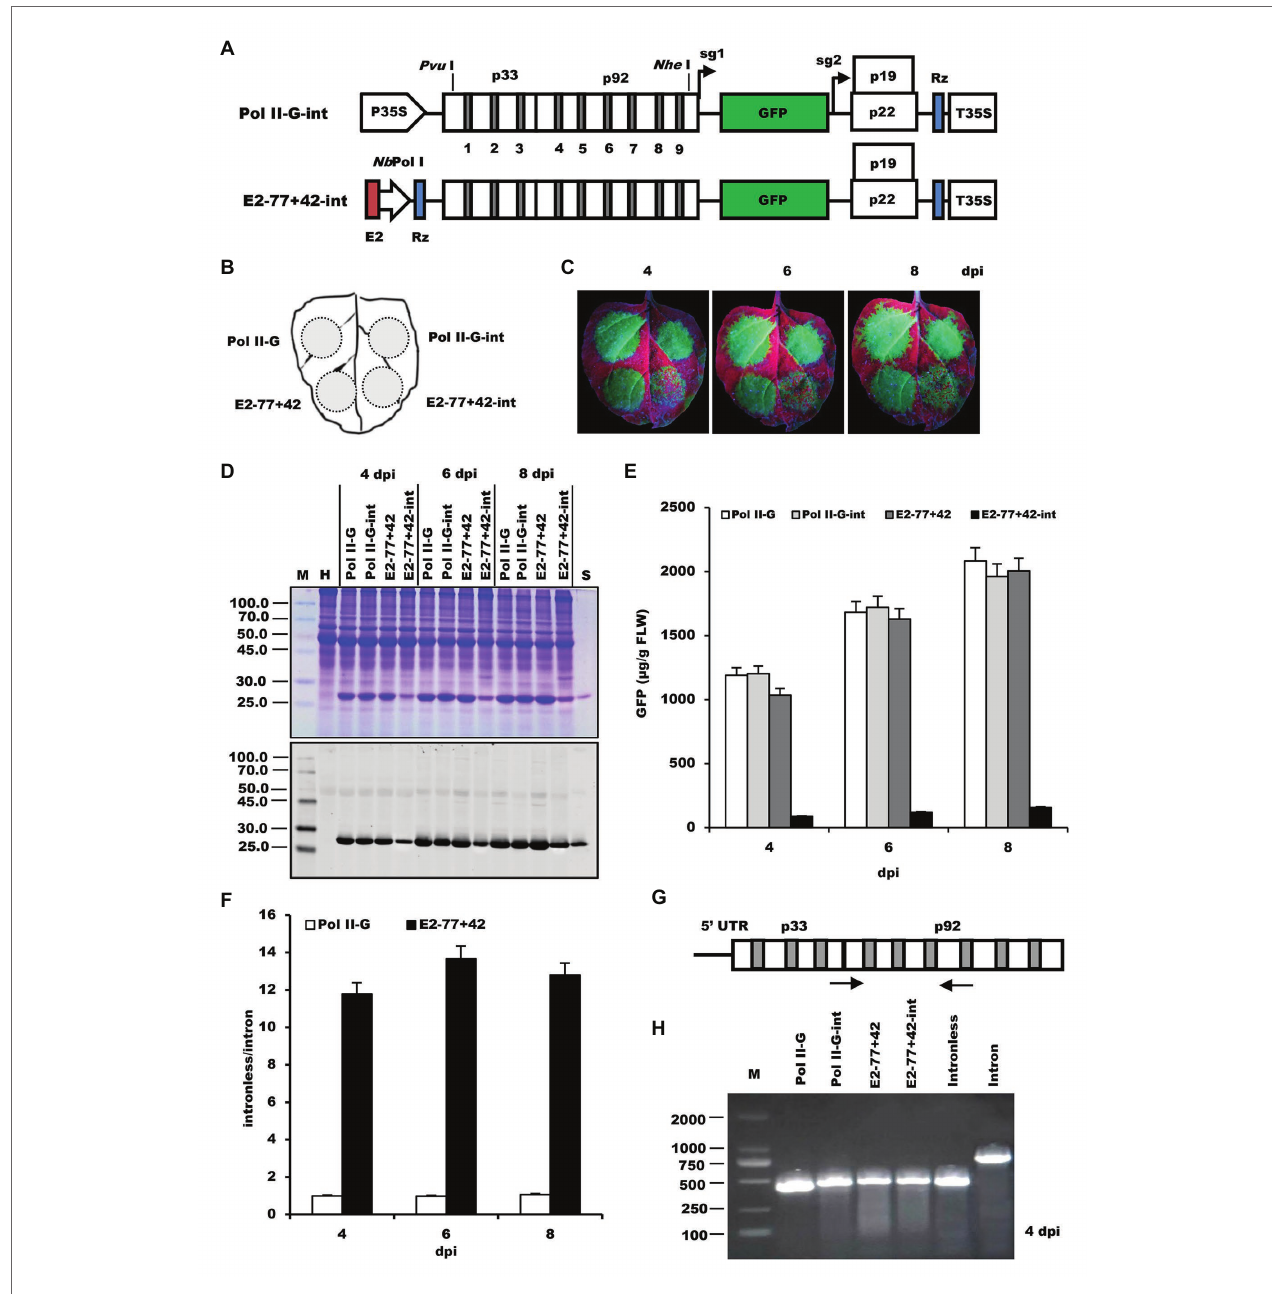
FIGURE 4 | Testing the transcription specificity of the Nicotiana benthamiana rRNA ( Nb rRNA) gene promoter by an intron-excision mediated assay. (A) Schematic representation of the intron-containing Pol I-promoter- or Pol II-promoter-based TBSV vectors. P35S, 35S promoter; p33 and p92, the gene coding replication proteins; sg1 and sg2, the TIS for subgenomic mRNAs 1 and 2 indicated by right-angled arrows; green fluorescent protein (GFP), enhanced green fluorescent protein gene; p19, silencing suppressor gene; p22, cell-to-cell movement protein (MP) gene; Rz, ribozyme; T35S, cauliflower mosaic virus (CaMV) polyA signal sequence/terminator; Pvu I and Nde I, restriction enzymes sites; E2, ELS from enhanced 35S promoter; Nb Pol I, modified Nb rRNA gene promoter ( − 77+42). The light gray box in the p33 and p92 regions shows the positions of the different introns. (B) Schematic representation of the infiltrated zones in N. benthamiana leaf. (C) GFP expression pattern (under UV light) of agroinfiltrated leaves at 4, 6, and 8 days post-inoculation (dpi), respectively. (D) SDS-PAGE analysis and immunodetection of proteins isolated from the agroinfiltrated leaves. The gel was stained with Coomassie brilliant blue (upper panel) and the corresponding antibodies were used to detect GFP (lower panel) by Western blots. M, molecular weight marker (kDa); H, Protein extracts from uninoculated leaves; Pol II-G, Pol II-G-int, E2 − 77+42, and E2 − 77+42-int, protein extracts from the corresponding infiltrated zones of N. benthamiana leaves in (C) . (E) Time course for the accumulation of GFP in infiltrated leaves by ELISA. (F) The ratios of GFP accumulation between intronless/intron-containing constructs. (G) The map of introns in the p33 and p92 region and the position of their reverse transcription PCR (RT-PCR) primers. (H) The RT-PCR analysis of introns in p33 and p92 at 4 dpi. Lane M: DNA molecular standards (bp); Pol II-G, Pol II-G-int, E2 − 77+42, and E2 − 77+42-int, total RNAs from the corresponding infiltrated zones of leaves in (C) ; Intronless, synthesized p33 and p92 sequences without introns; Intron, synthesized p33 and p92 sequences with